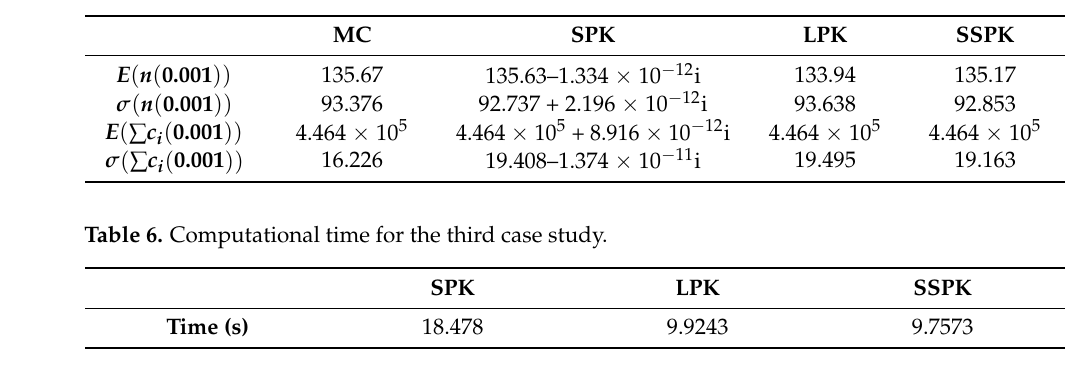
Figure 2. Population for the third case study. ( a ) Neutron population. ( b ) Precursor population. Table 5. Population for the third case study at time t = 0.001 s.